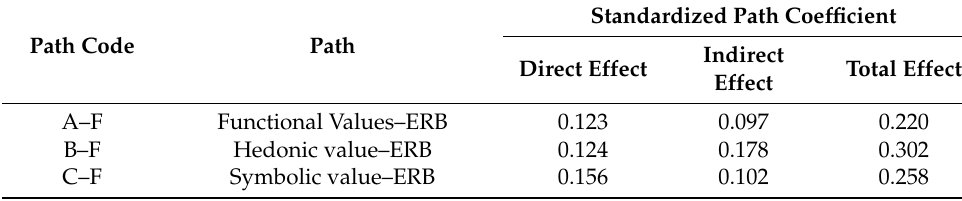
Table 6. Analysis of the effect of place